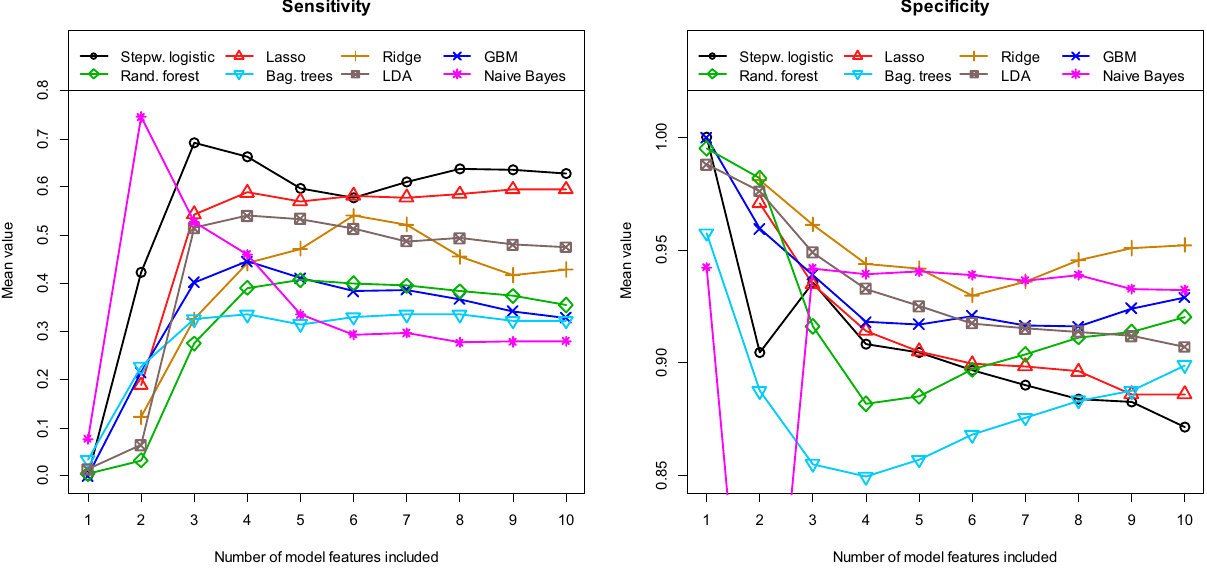
Figure 6. Sensitivity and Specificity for the test samples, calculated as means of 100 repetitions (100 cycles).